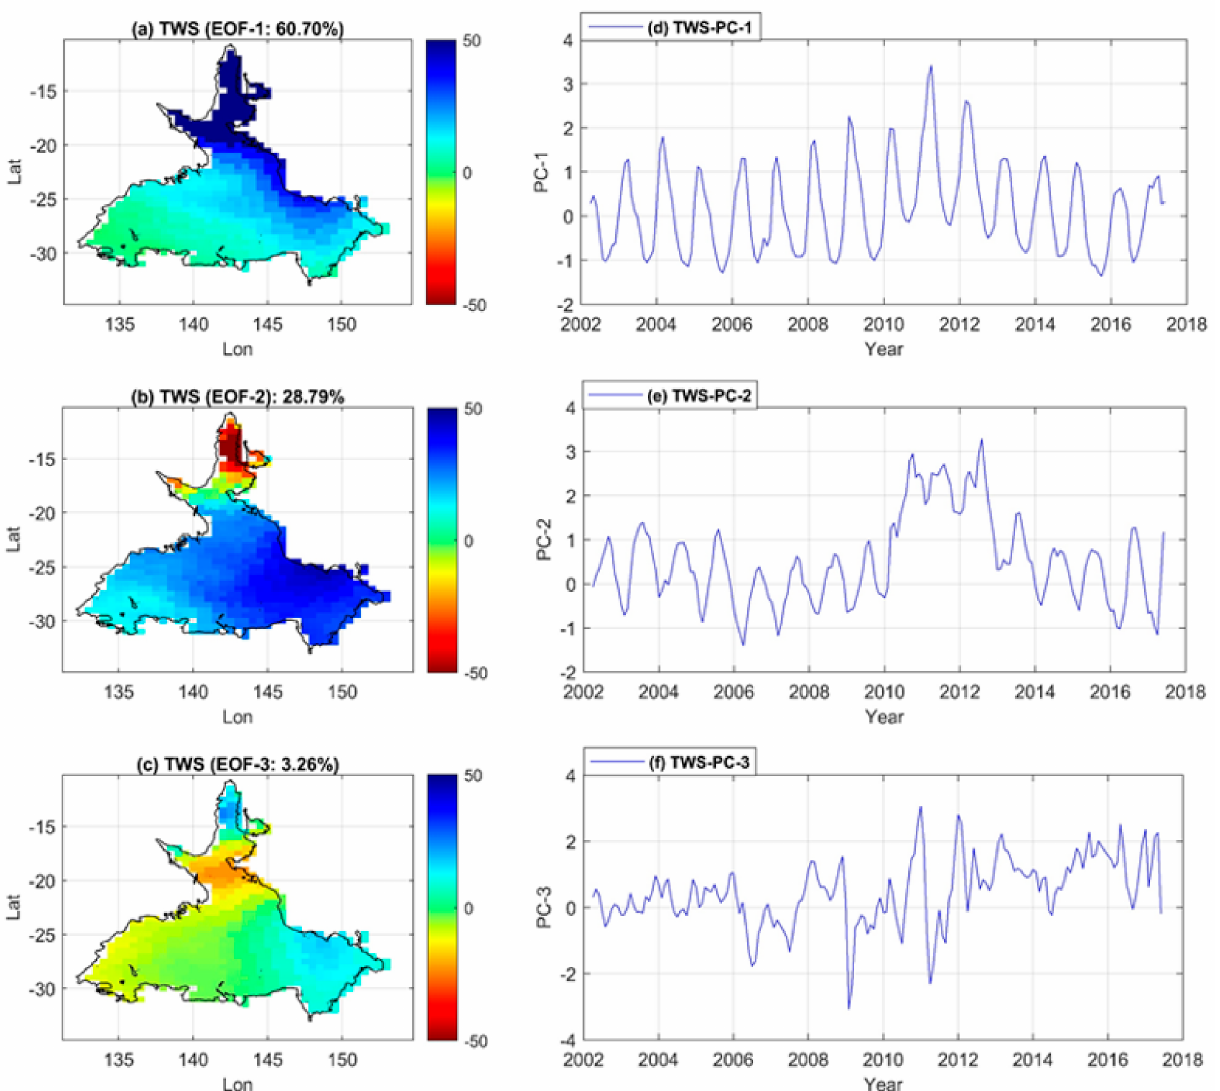
Figure 4. Spatio-temporal patterns of terrestrial water storage (2002–2017) over the GAB using principal component decomposition. The amplitudes on the y-axis (in the lower row) are normalized using standard deviations (unitless). The upper row highlights the corresponding spatial patterns (unit: mm) to these temporal patterns. The collective interpretation of temporal patterns in ( d – f ), and their corresponding spatial patterns in ( a – c ) provide the details of the variations in terrestrial water